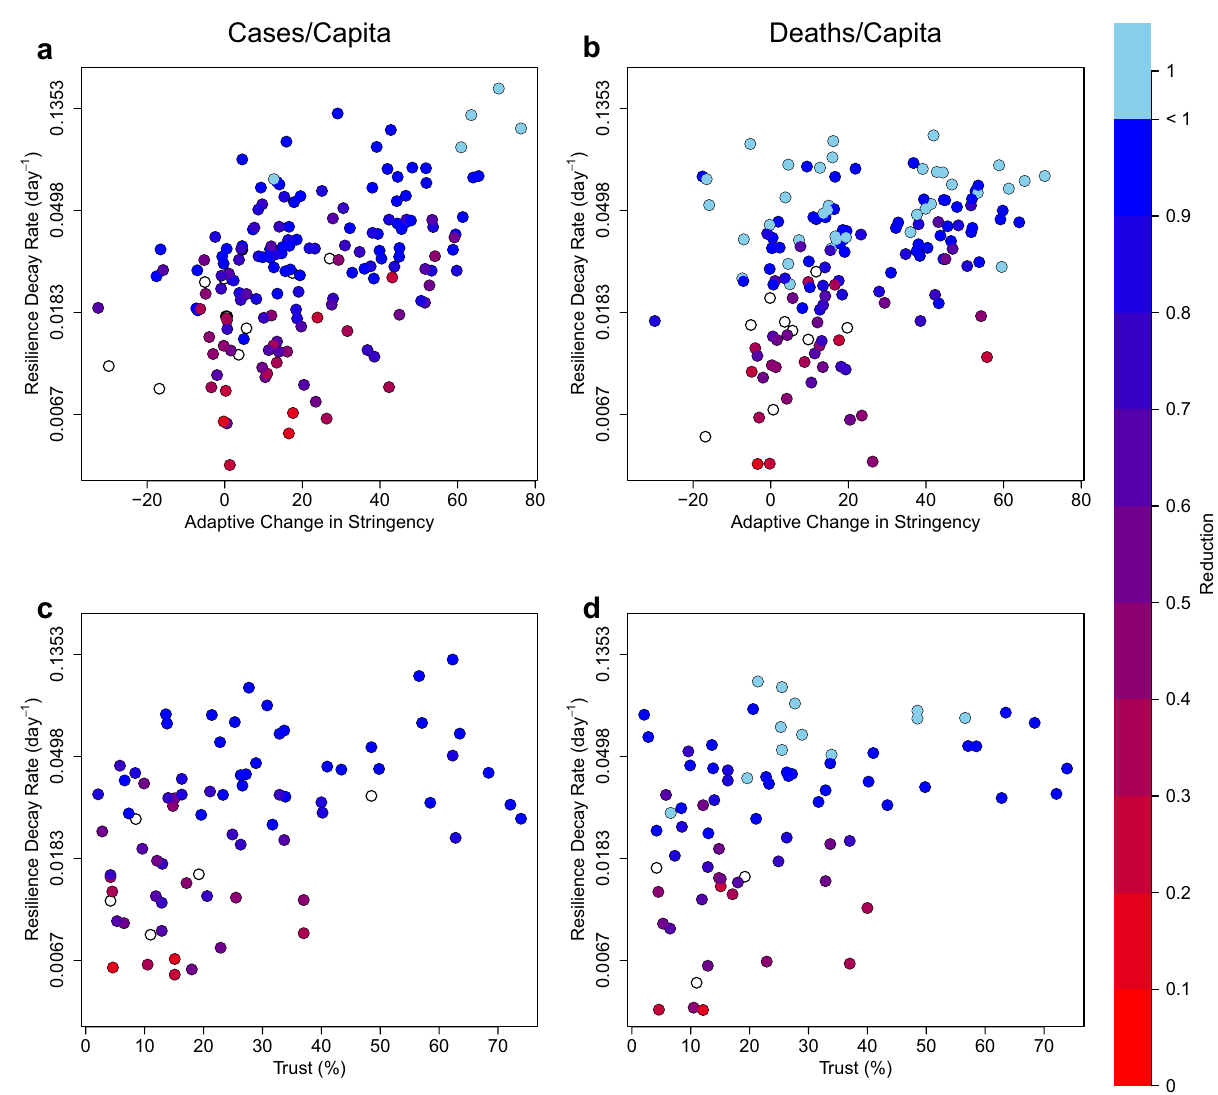
Figure 5. Country-level relationships between adaptive stringency or trust, resilience to COVID-19 and resulting reduction of cases and deaths. ( a ) cases/capita: relationships between adaptive stringency and resilience (n = 167, ρ =0.47, p < 0.0001) and between adaptive stringency and reduction (n = 156, ρ =0.29, p < 0.001). ( b ) deaths/capita: relationships between adaptive stringency and resilience (n = 153, ρ =0.39, p < 0.0001) and between adaptive stringency and reduction (n = 144, ρ =0.21, p < 0.05). ( c ) cases/capita: relationship between trust and resilience (n = 77, ρ =0.43, p < 0.0001) and between trust and reduction (n = 72, ρ =0.51, p < 0.0001). ( d ) deaths/capita: relationship between trust and resilience (n = 75, ρ =0.40, p < 0.001) and between trust and reduction (n = 72, ρ =0.48, p < 0.0001). Note the threshold effect whereby trust > 40% (of population agreeing with the statement “most people can be trusted”) ensures resilience of cases/capita > 0.02 d −1 and deaths/ capita > 0.03d −1 , which in turn support successful reduction of cases and deaths. Cases of complete reduction— i.e. elimination of cases or deaths—are denoted with pale blue. Cases where reduction is incomplete at the end of the timeseries are denoted with open circles. The trust-reduction relationships are further analysed in Supplementary Fig.